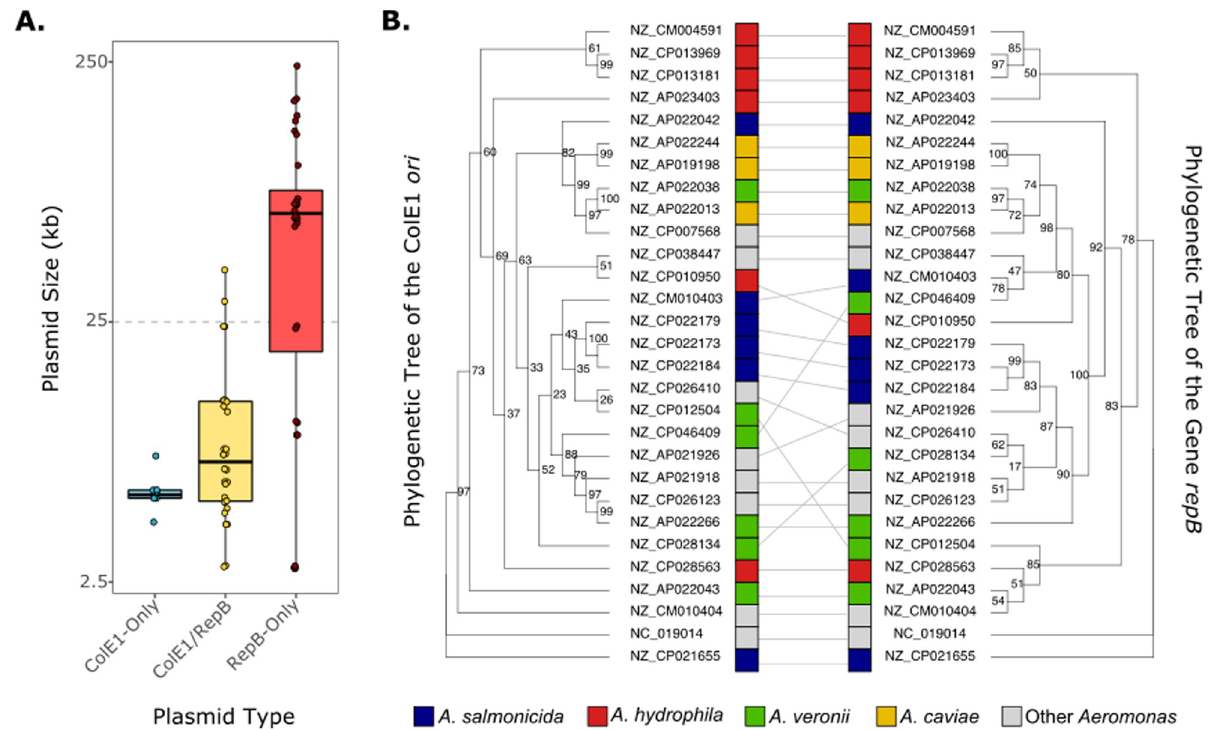
Fig 3. ColE1/RepB plasmids in Aeromonadales . A . Size of the ColE1/RepB plasmids (log scale) per category: ColE1-only (n = 8), ColE1/RepB (n = 30) and RepB-only (n = 28). The horizontal gray dashed line separates the small ( < 25kb) from the large plasmids ( > 25kb). B . Tanglegram of the ColE1 origin of replication (left) (best-fit model JTT+G4) and the gene repB (right) (TN+F+I+G4). The bootstrap values of the trees are indicated with numbers next to each node. The accession numbers and host Species of the plasmids are indicated at the tips of the branches.